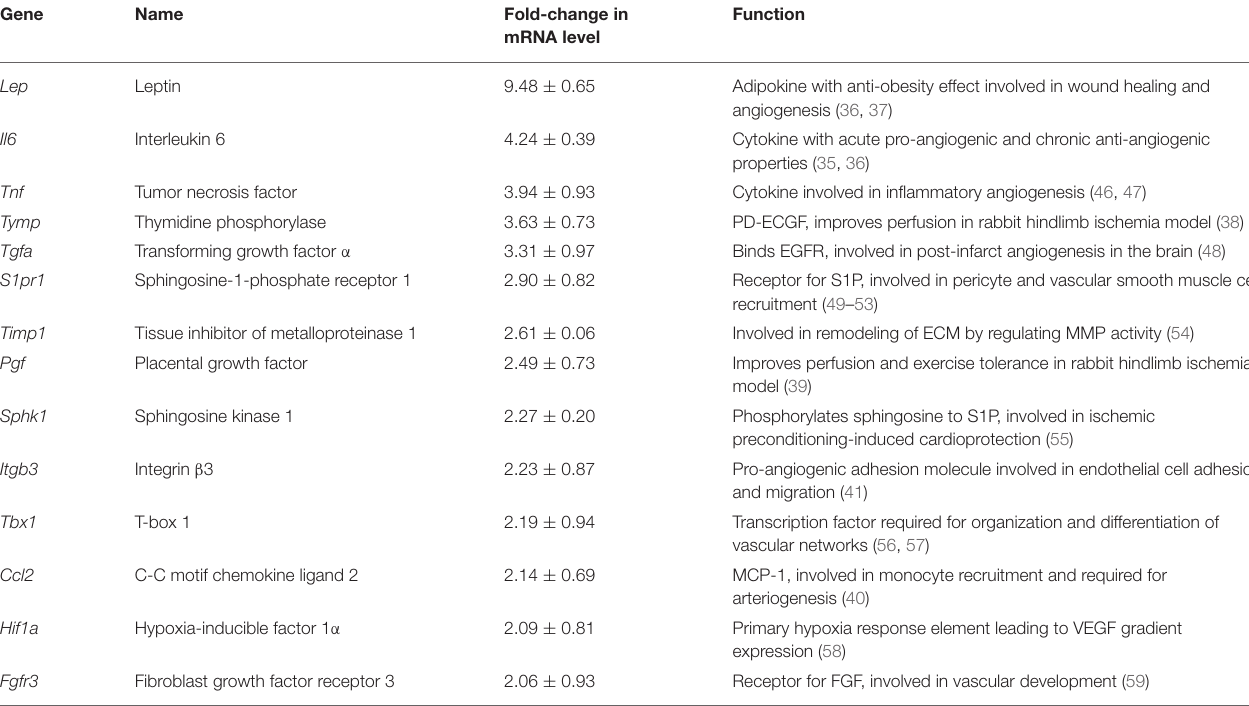
TABLE 1 | Name and function of angiogenesis genes modulated by intramuscular E-selectin/AAV2/2 gene